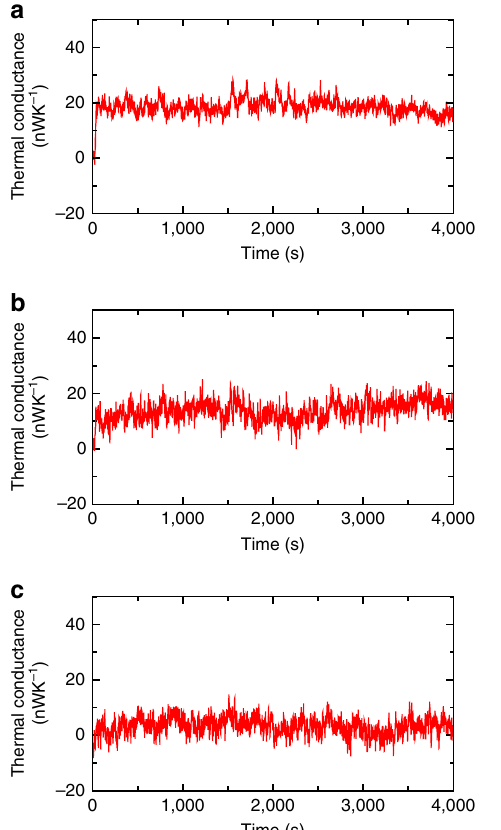
Figure 4 | Time-dependent thermal conductance for probes subjected to different cleaning procedures. ( a – c ) Thermal conductance as a function of time for probes subjected to the cleaning procedures as described for Fig. 2a–c, respectively.